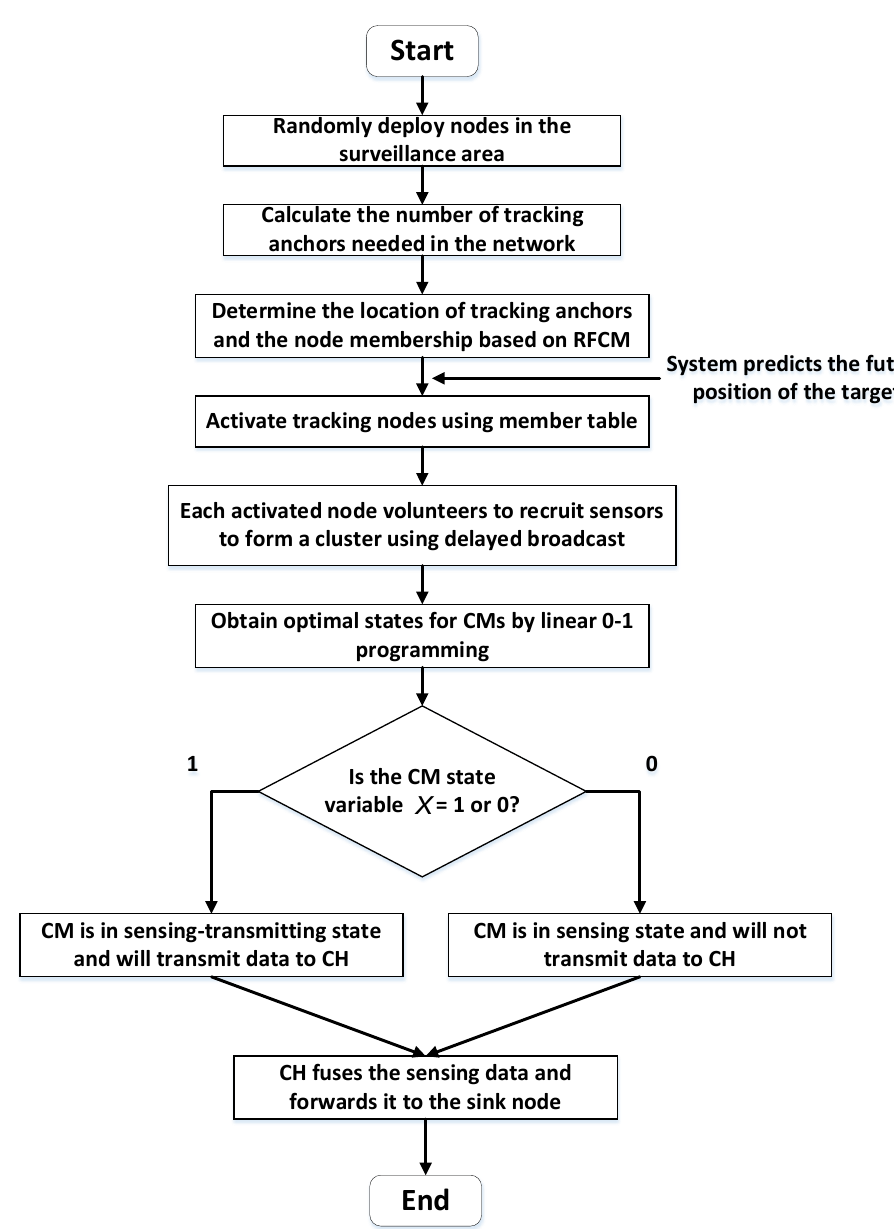
Figure 8. Workflow of the proposed algorithm.